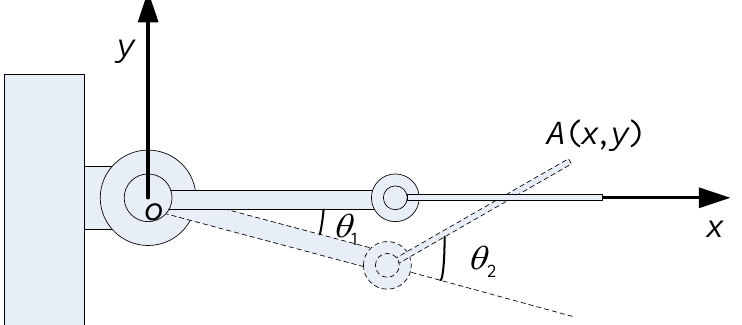
Figure 7. Coordinate system of the experiment.